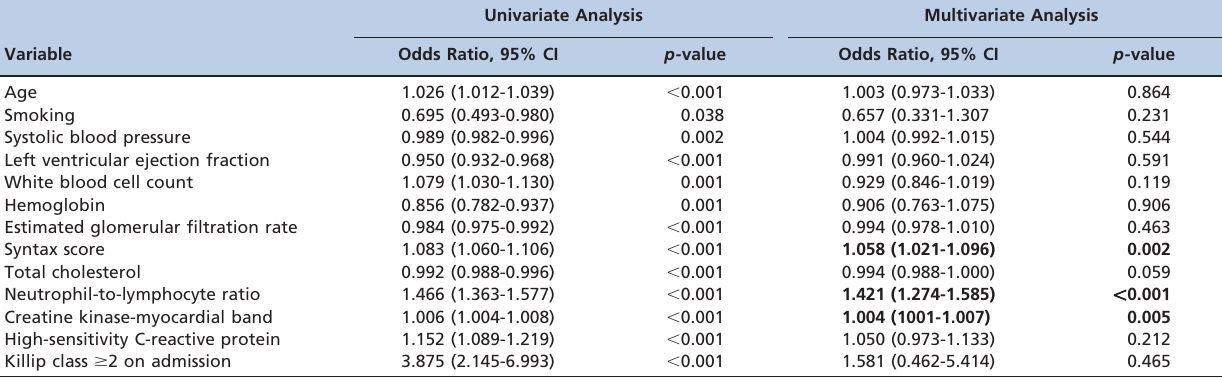
Table 4 - Univariate and multivariate predictors of Thrombolysis In Myocardial Infarction 0 flow grade in ST-segment elevation myocardial infarction after wire insertion.